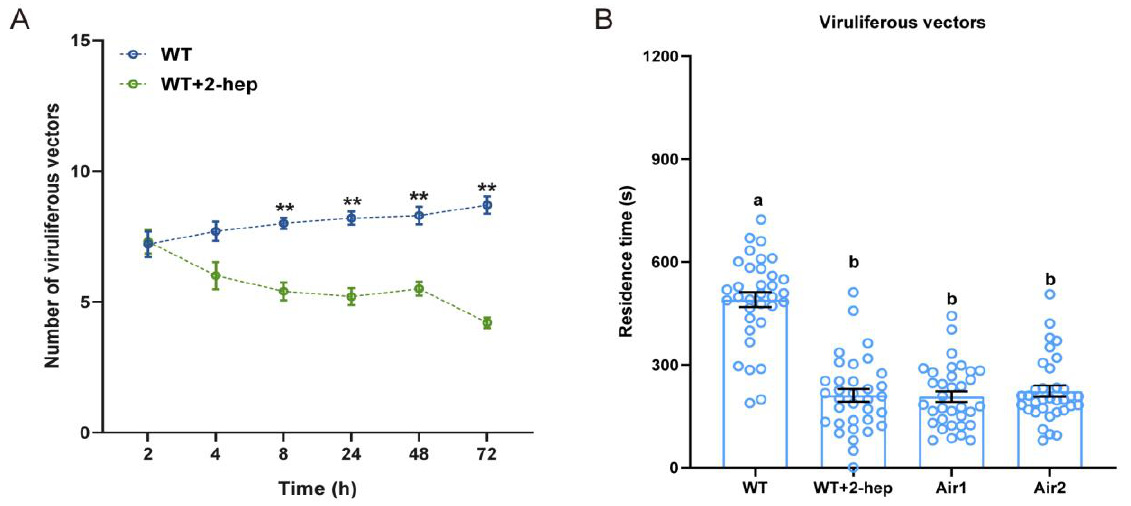
Figure 6. The effects of 2-heptanol sprayed on rice plants on the feeding and plant odor preferences of viruliferous N. virescens : ( A ) Feeding preference of viruliferous N. virescens between WT plants plus 10 μL pure lanolin paste (control plants) and WT plants plus synthetic 2-heptanol (2-hep, 8.17 μg) in 10 μL of lanolin (treated plants). WT, wild type (Minghui63, MH63) (RDV-free). All feeding choice assays were performed with fifteen biological replicates, each of fifteen newly emerged adults. The statistical difference between the two treatments in the same column is indicated by asterisks (** p < 0.01, Wilcoxon’s signed-ranks tests). Data are mean ± standard error. ( B ) Plant odor preference of viruliferous N. virescens between control plants and treated plants ( n = 34). WT, WT plant odors; WT + 2-hep, WT plants plus synthetic 2-heptanol odors; Air1, clean air; Air2, clean air. Deviations from equal distributions were analyzed with a Friedman–ANOVA ( p < 0.05). Bars annotated with different letters are significantly different from each other (Wilcoxon–Wilcox test). Data are mean ± standard error.